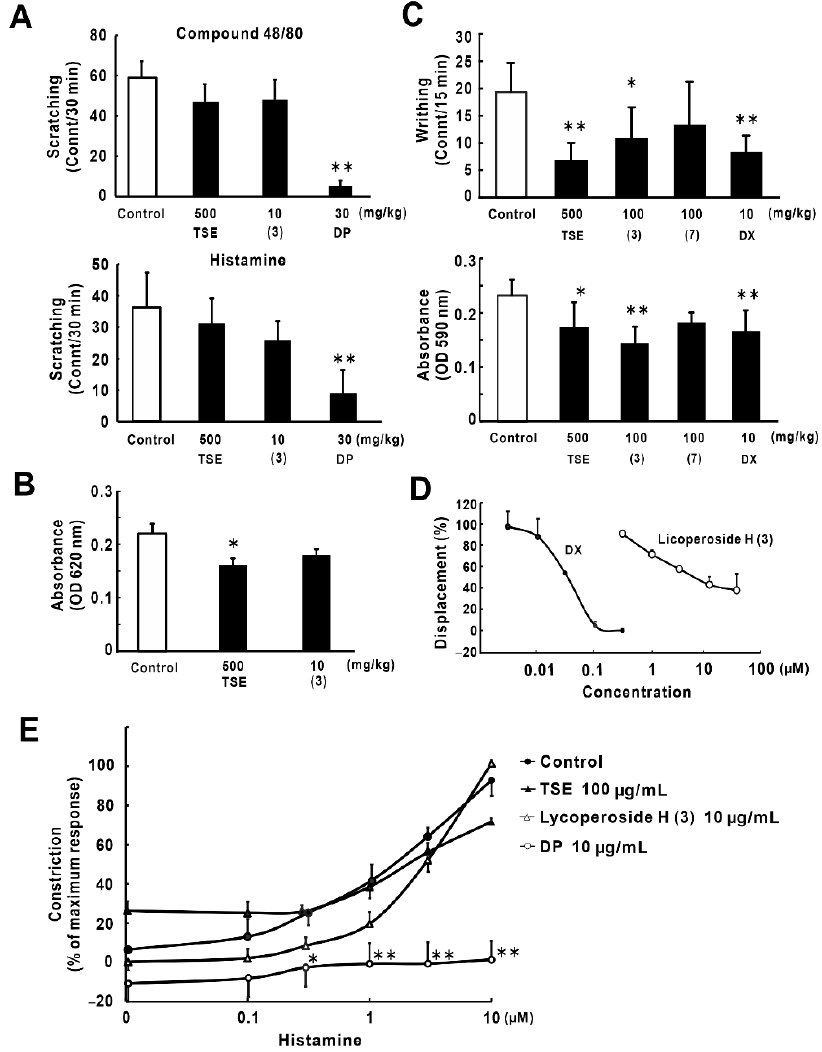
Figure 5. Anti-inflammatory and anti-allergic effects of lycoperoside H ( 3 ) and its relations to glucocorticoid and histamine. ( A ) Effect on compound 48/80- and histamine-induced scratching behaviors in mice ( n = 5–7). Pruritus was induced by the subcutaneous administration of compound 48/80 or histamine dihydrochloride. Diphenhydramide hydrochloride (DP) was used as a positive control. ( B ) Effect on the PCA reaction in mice ( n = 10–14). Both the right and left mouse